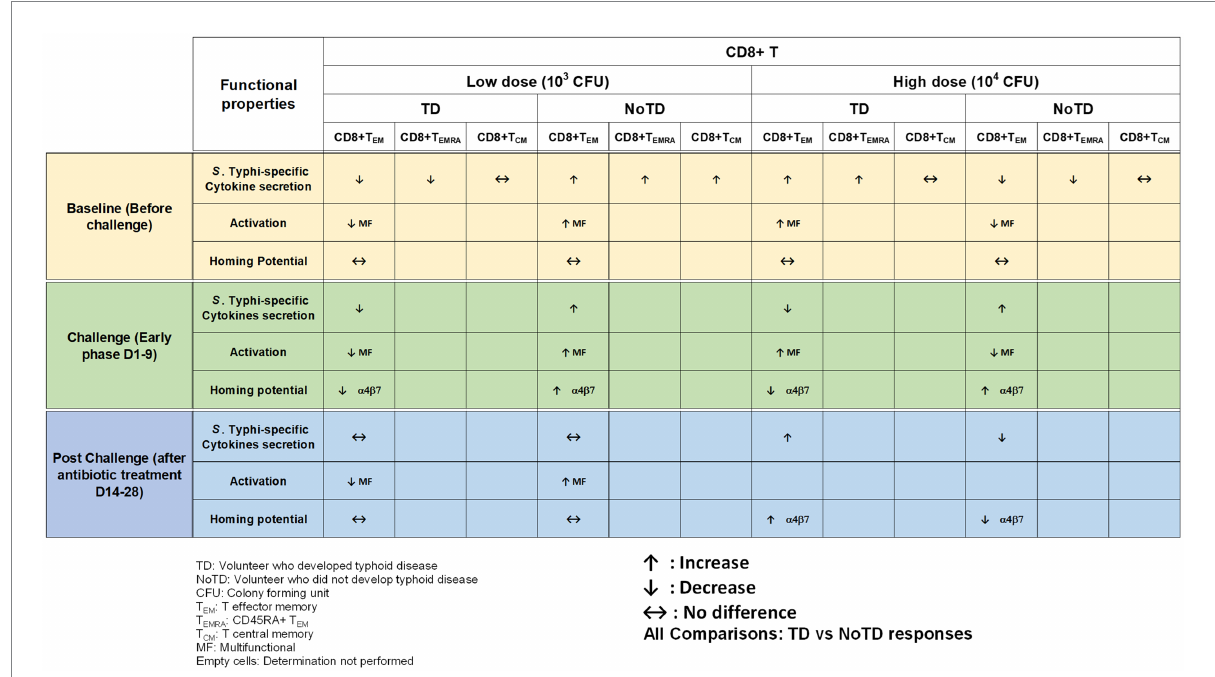
FIGURE 4 Memory CD8+ T cells responses in a typhoid CHIM. Summary of S . Typhi-specific CD8+ T memory cell responses reported by Fresnay et al. (2016, 2017), including comparisons between TD and NoTD at baseline (before challenge), early days after challenge (D1-9) and at later time points after challenge (D14-28) with either of two doses of wt S . Typhi (Low: 10 3 CFU and high: 10 4 CFU). ↑ : Increase; ↓ : Decrease; ↔ : No